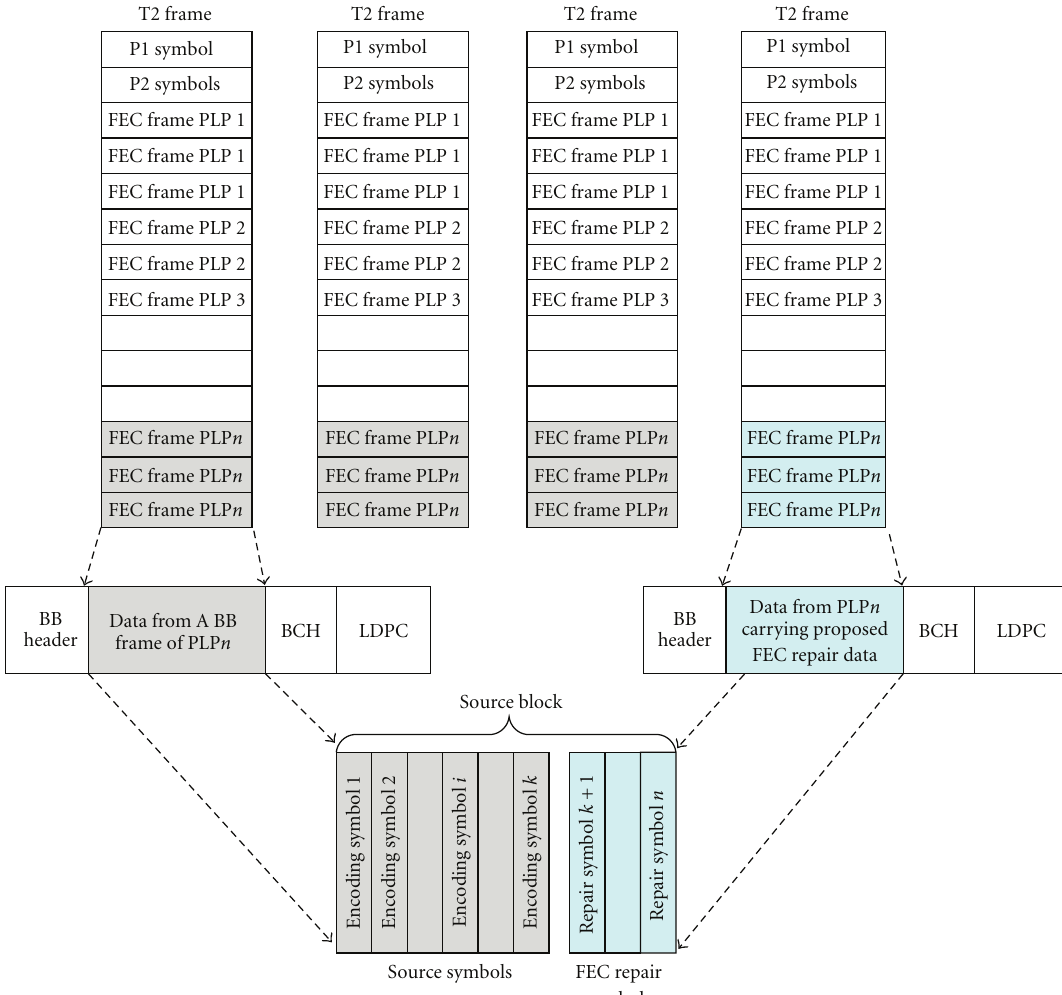
Figure 12: Example of a construction of a link layer FEC